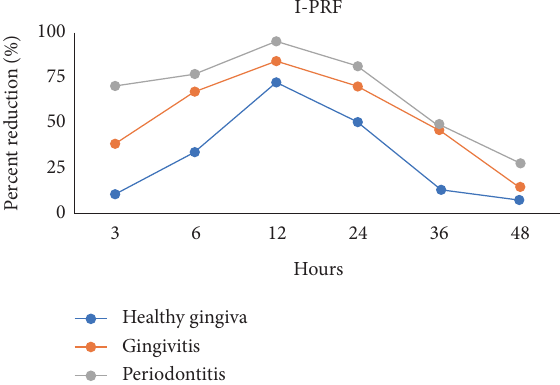
Figure 1: Te percent reduction in the number of bacterial colonies compared to the control under the infuence of A-PRF+ from the three groups at 3, 6, 12, 24, 36, and 48h.